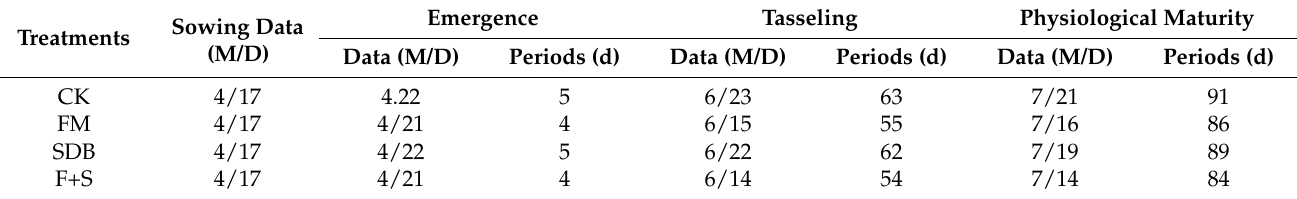
Table 5. The growth process of maize.